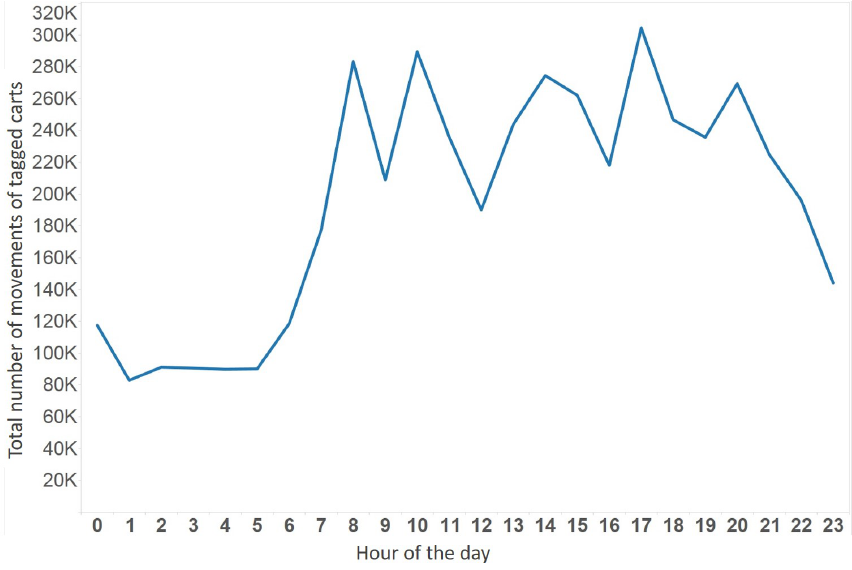
Figure 10. The total number of movements of all tagged carts in different